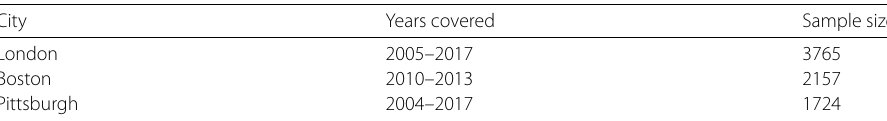
Table 1 Basic information for our bike accident data City Years